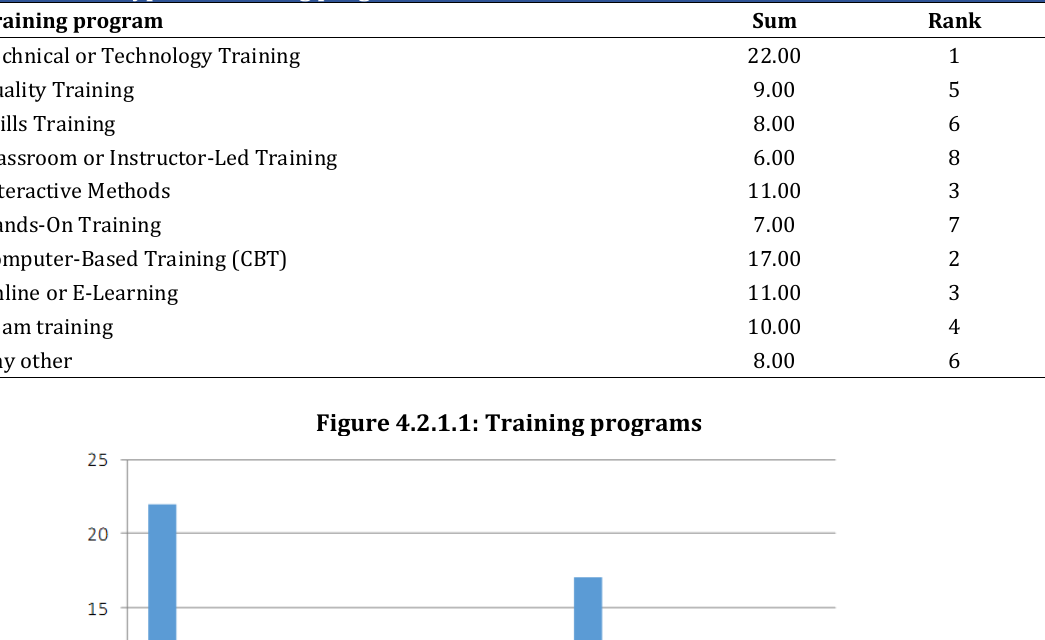
Table 4.2.1: Types of training program